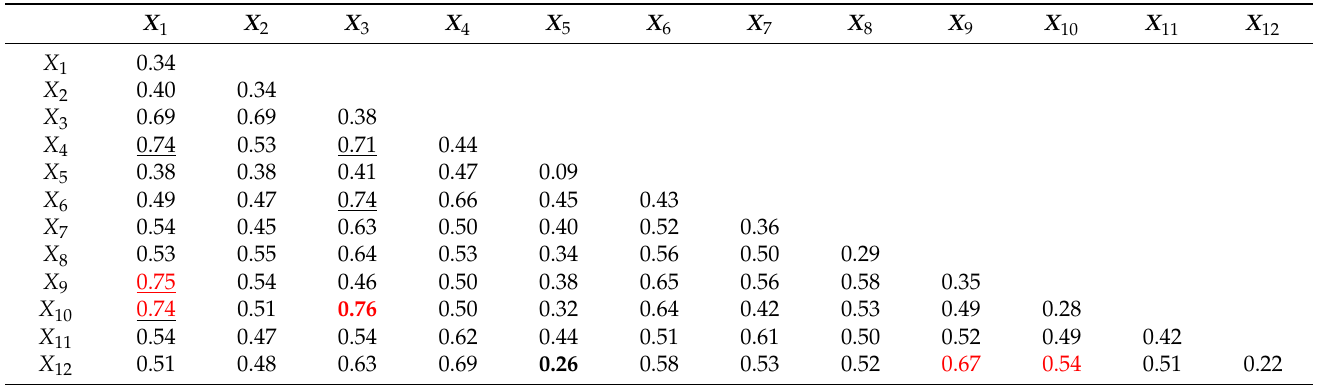
Table 6. Analysis of the evolution mode of independent variables in 2015–2019.